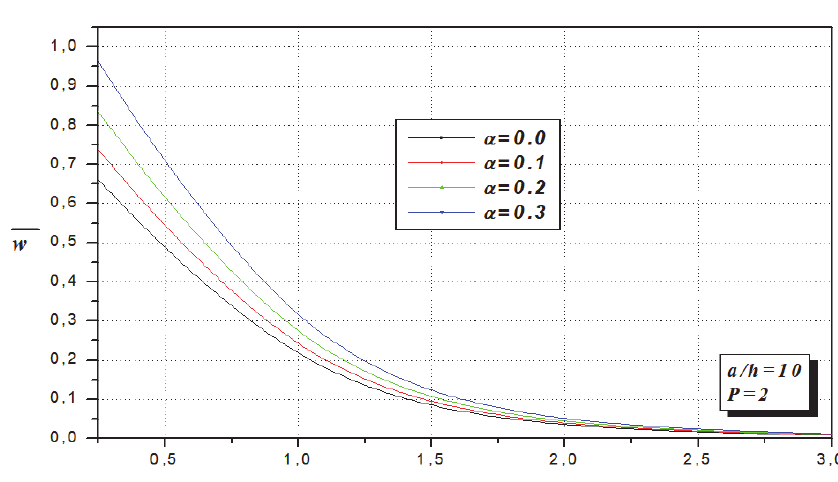
Figure 6: Variation of dimensional displacement as a function of the geometric ratio a/b for the different values of porosity coefficient for plate sandwich FGM.